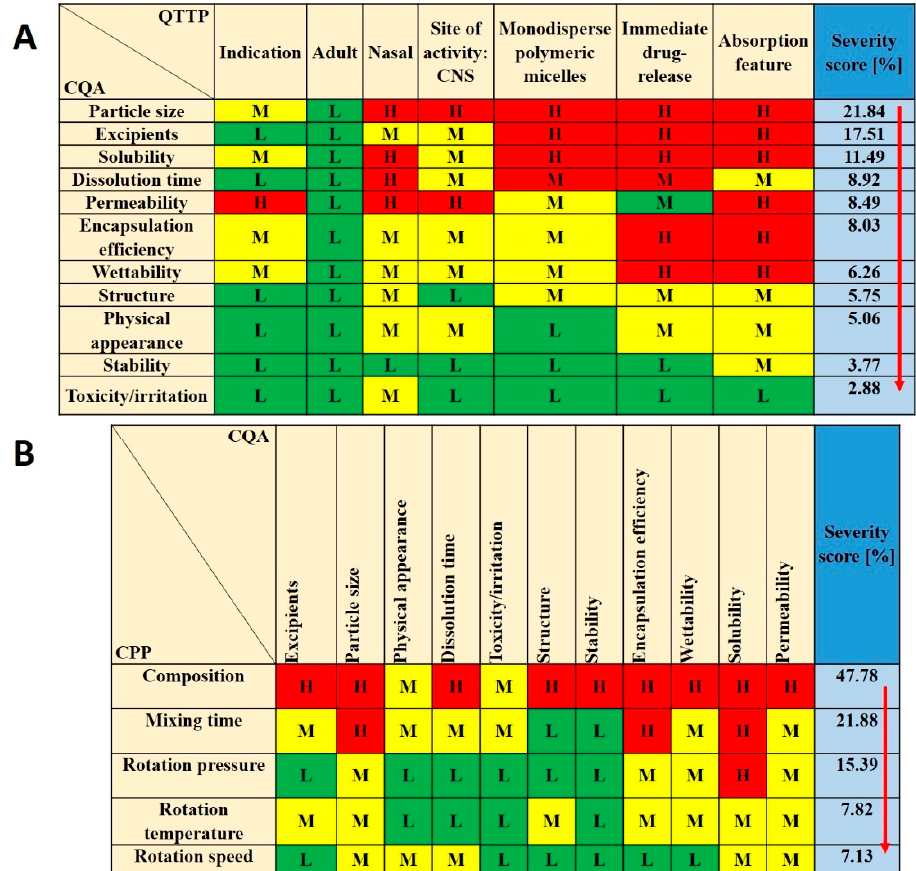
Figure 1. Ishikawa—or cause and e ff ect diagram—of the influencing parameters of meloxicam (MEL)-containing polymeric micelles for intranasal use. Abbreviations not mentioned before: HLB—hydrophile–lipophile balance; GI—gastrointestinal; MCC—mucociliary clearance.